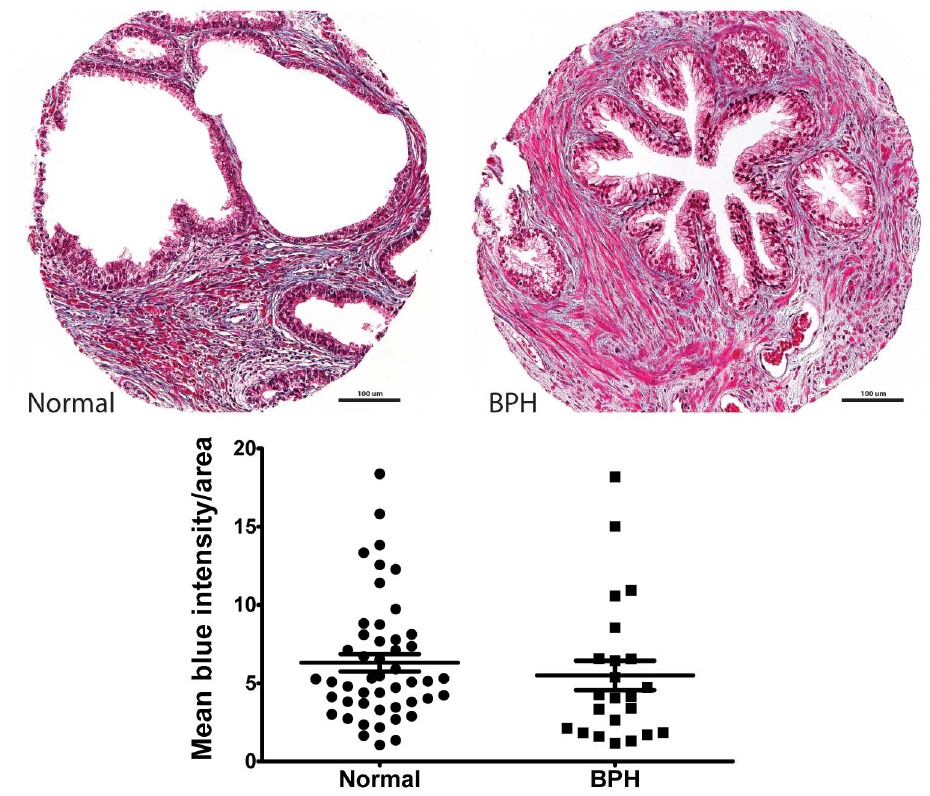
Figure 1. Extracellular matrix content is similar in normal prostate tissue and glandular BPH. The tissue microarray (TMA) was stained with Masson’s trichrome for detection of cellular and extracellular matrix (ECM) contents. Blue coloration, indicative of ECM, was separated for all cores by manual thresholding of hue (121–179), saturation (20–255), and brightness (10–255) values in ImageJ, and ECM content was quantified as mean blue intensity per tissue area. ECM composition was similar in normal prostate (mean=6.308; SEM=0.560) and glandular BPH (5.496 6 0.940; p=0.44).